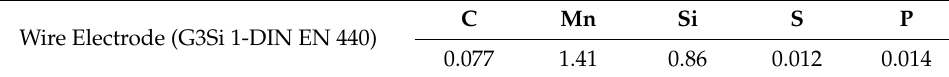
Table 2. Chemical composition for the wire electrode.